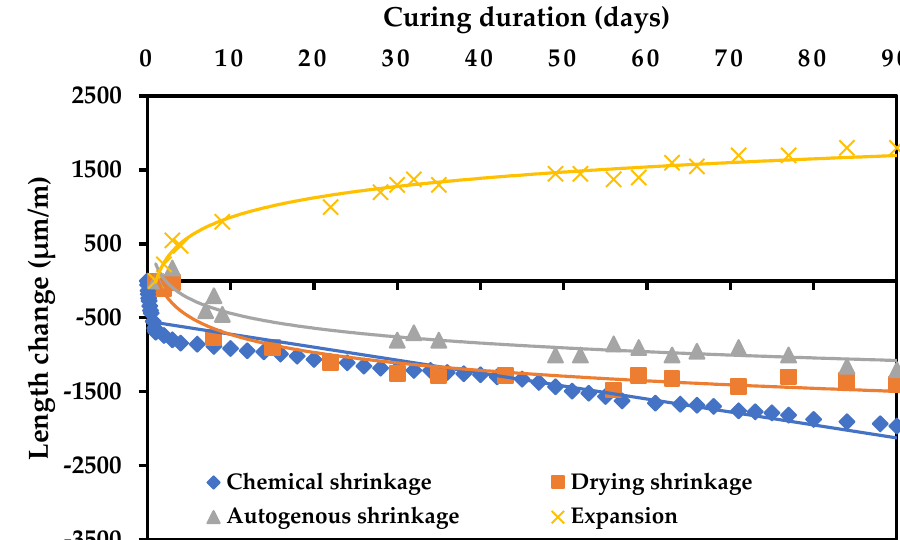
Figure 11. Length change of pastes with 5% LF.